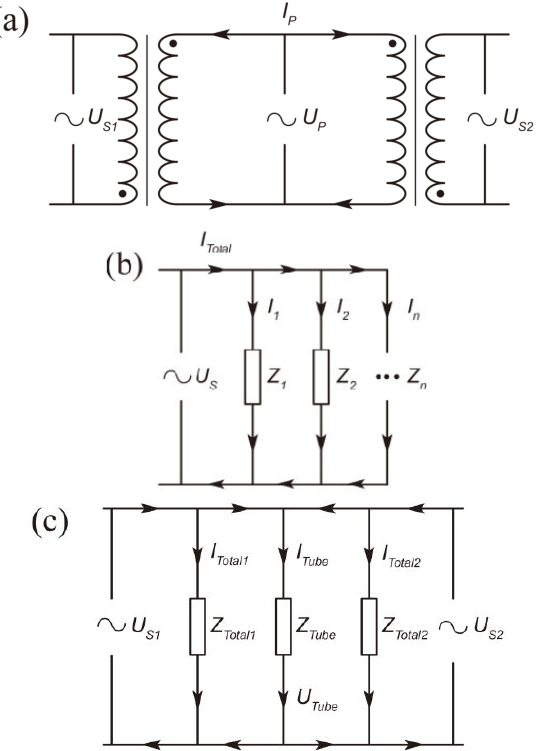
Figure 2. Equivalent circuit of primary and secondary coils ( a ), 106 unit ( b ), and IEF system ( c ). Theoretically, the voltage ( U Tube ) between the link tube is equal to U S 1 and U S 2